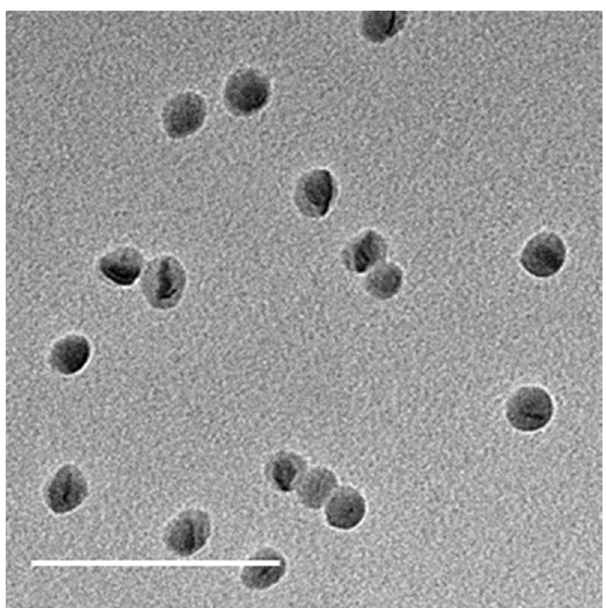
Fig. 3 TEM image. TEM image of polyethylene particles synthesized by encapsulating L 1 Pd-NR 3 in micelles of PEG-PCF 3 and pressurizing with ethylene for 1 h at 40 bar and 85 °C (Table 2, entry 2). Scale: 500 nm. Additional images available in SI (Supplementary Fig. 13, images a and